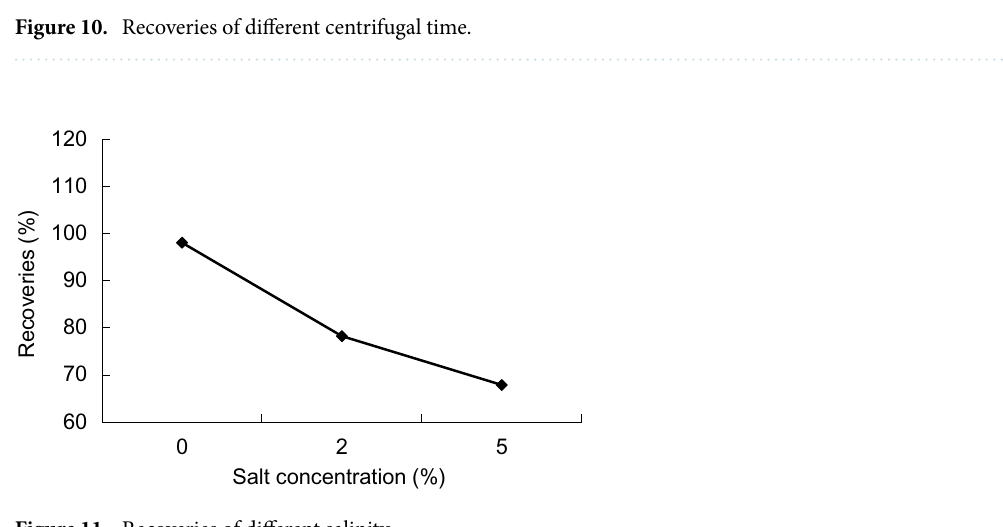
Figure 11. Recoveries of different